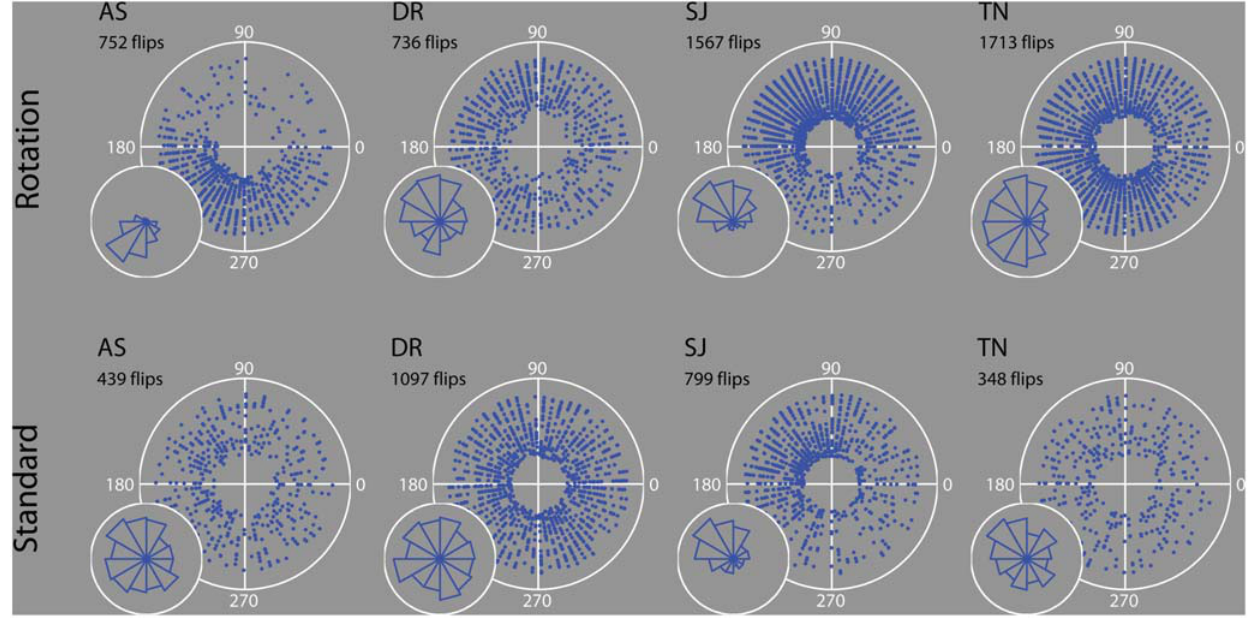
Figure 6. Response location distributions. Polar plots illustrate the estimated reversal locations (i.e. RT-corrected) for the rotating (upper row) and standard walker (lower row) stimuli presented in Experiment 2, combined across all repetitions. For the standard walker, angular location refers to the phase of the walker’s step-cycle, which was identical to the rotating walker step-cycle. Distance from the centre of the polar plot illustrates how far in time into a trial a response occurred i.e. successive rotation periods span out from the centre in concentric pattern. Note that an artificial gap is added to the centre of each plot, to avoid crowding of dots in the centre. Chi-squared tests verified that each of the rotating walker histograms deviated significantly from a uniform distribution. Rotating–AS: x 2 =644.6, p , 10 2 15 ; DR: x 2 =65.5, p , 10 2 9 ; SJ: x 2 =637.2, p , 10 2 15 ; TN: x 2 =153.1, p , 10 2 15 . Standard–AS: x 2 =14.5, p=0.208; DR: x 2 =16.5, p=0.12; SJ: x 2 =245.5, p , 10 2 15 ; TN: x 2 =18.1, p=0.07 (df=11 for all).